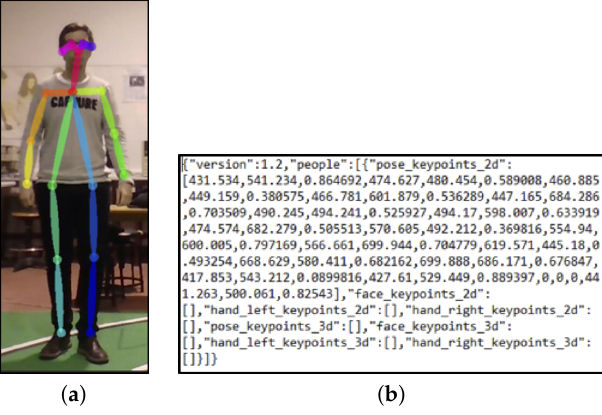
Figure 5. The human pose model: ( a ) The feature points, in circles with different colours, of the OpenPose human body 18 nodes model; ( b ) a sample of the json file, only with the 2D node